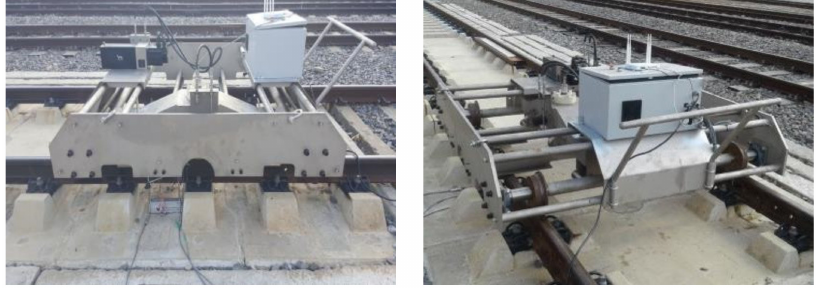
Figure 16. Photograph of field